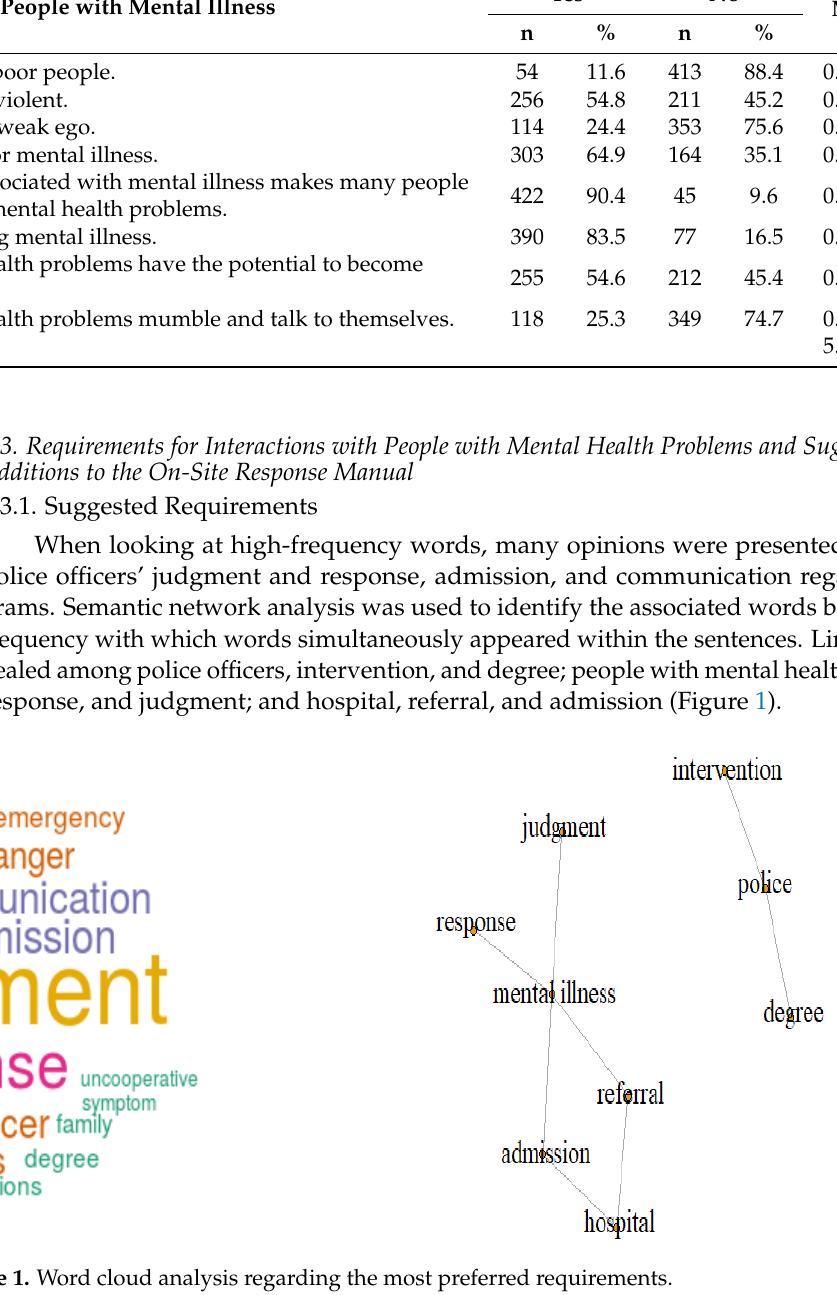
Table 3. Social perceptions of people with mental health problems by police officers (N = 467). Thoughts on People with Mental Illness